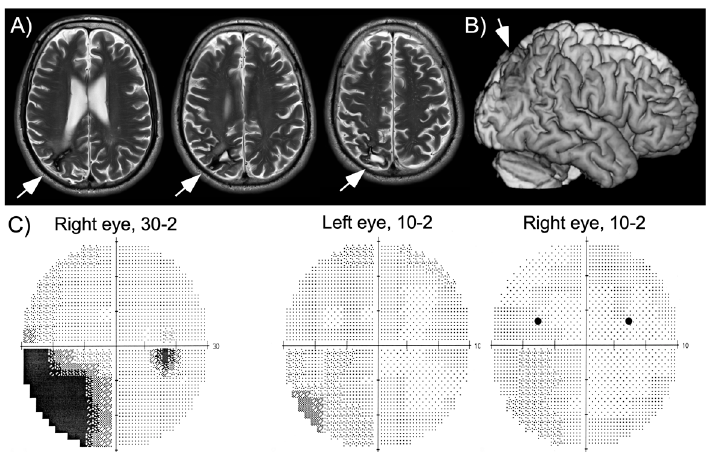
Figure 1. Magnetic resonance imaging (MRI) scan and visual field plot of the patient. ( A ) Axial slices at three different levels of the parietal lobe (images shown according to radiological convention, left is on the right). ( B ) Three-dimensional reconstruction of the patient’s brain, showing the small lesion in the superior parietal cortex. ( C ) Visual field plots (Humphrey Perimeter; 30-2 plot: sensitivity tested up to 30 degrees into the left and right hemifield; 10–2 plots: sensitivity tested for the central 10 degrees; inter-stimulus distance was always two degrees). Testing of the sensitivity up to 30 degrees in the periphery shows incomplete left lower quadrantanopia. More detailed testing of the central 10 degrees shows intact central visual fields. The two black dots indicate positions where targets were presented.